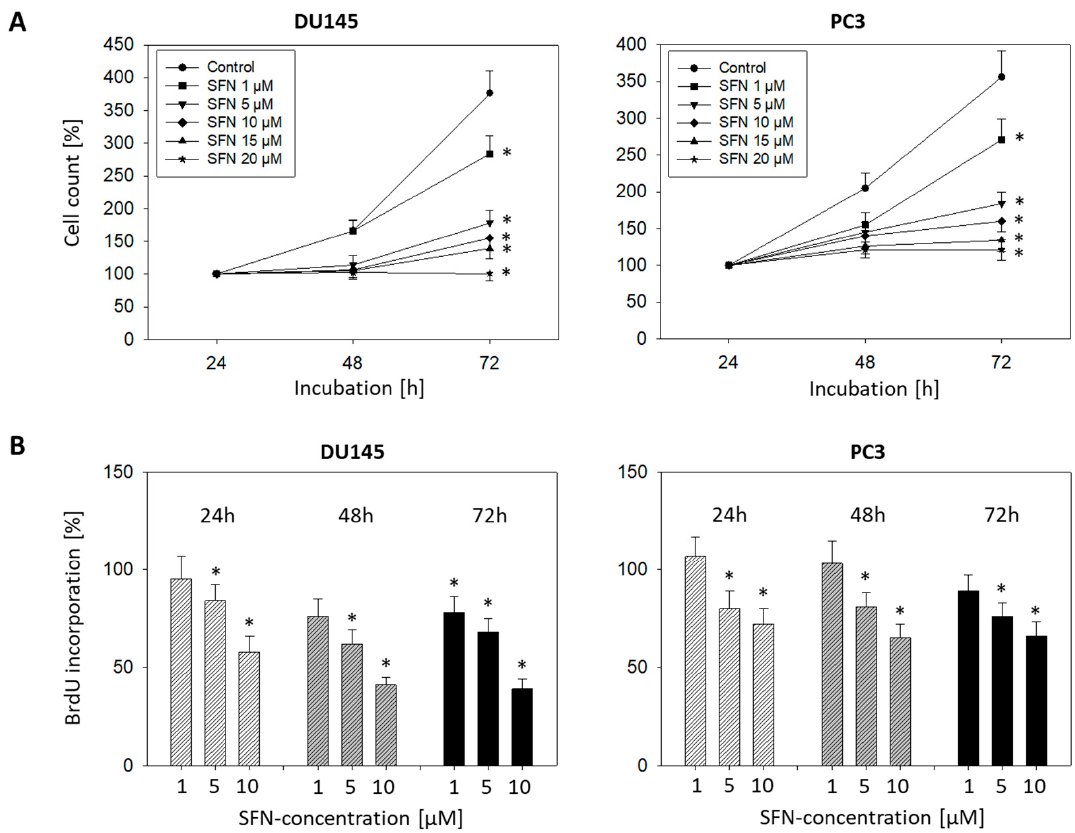
Figure 1. ( A ): Influence of 1–20 µM sulforaphane (SFN) on cell growth of DU145 and PC3 cells. Cell number evaluated after 24 (100%), 48, and 72 h by MTT assay. Whiskers indicate standard deviation, * = p ≤ 0.05, n = 6. ( B ) Influence of 1, 5, and 10 µM SFN on proliferation of DU145 and PC3 cells. Evaluation by BrdU incorporation after 24, 48, and 72h. Whiskers indicate standard deviation. * Indicates significant difference to untreated controls set to 100%, p ≤ 0.05. n = 3.